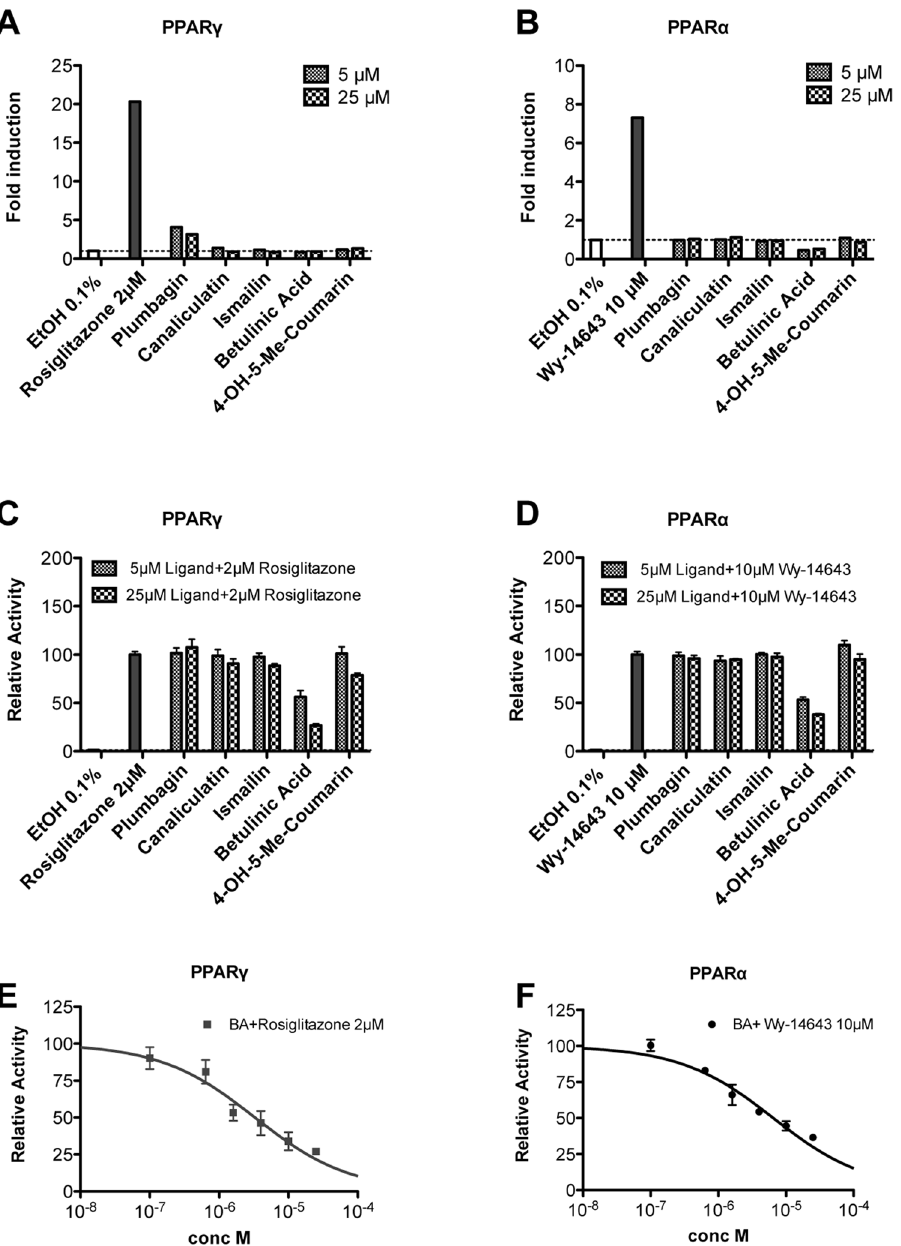
Figure 2. Transactivation assay and antagonist effect of the five ligands towards PPAR γ and PPAR α in HepG2 cells. Fold induction at two concentrations (5 and 25 μ M) of the five compounds over vehicle (EtOH, 0.1%) on ( A ) PPAR γ and ( B ) PPAR α as determined by luciferase-based transactivation assays. Reference compounds: rosiglitazone (2 µ M) and Wy-14643 (10 µ M). Plumbagin was the only PPAR γ partial agonist in the series (Emax = 19 ± 2% compared with rosiglitazone), and the others were inactive. For plumbagin, it was not possible to calculate EC 50 , because of its cytotoxicity starting from 25 µ M. No PPAR α transactivation was observed in response to any ligands. The antagonist effect of the five ligands on ( C ) PPAR γ and ( D ) PPAR α was measured at two concentrations (5 and 25 μ M) on Gal4–hPPAR γ LBD or Gal4–hPPAR α LBD transfected cells treated with rosiglitazone at 2 µ M or Wy-14643 at 10 µ M. Data from luciferase reporter assays indicated that only BA was able, at increasing concentrations, to displace ( E ) rosiglitazone from PPAR γ and ( F ) Wy-14643 from PPAR α with IC 50 values of 3.1 ± 1.2 μ M and 7.4 ± 1.8 μ M, respectively. All data are normalized with respect to control, and values are presented as the means ± SEM of n = 2 experiments performed in